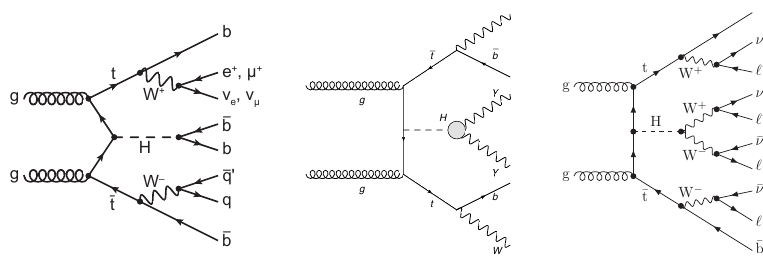
Figure 1. Feynman diagrams showing the t¯tH → b¯b decay that includes subsequent decays of the top quark- antiquark pair in the lepton + jets channel (left), the t¯tH with the Higgs boson decaying into a pair of photons, i.e. t¯tH → γγ (middle) and one possible Feynman diagram for t¯tH production, where the Higgs boson decays to WW ∗ , producing the final state with four leptons (right). Table 1. CMS and ATLAS t¯tH signal strength measurements obtained using the LHC Run I data.